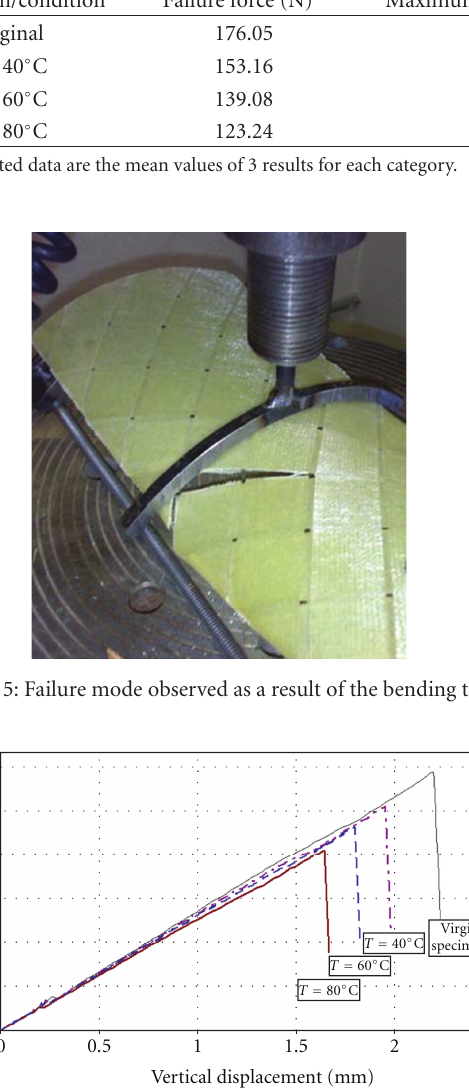
Figure 6: Plot of the average load versus displacement (each curve is the average of 3 specimens) for the specimens conditioned at dif- ferent temperatures at 60% humidity.